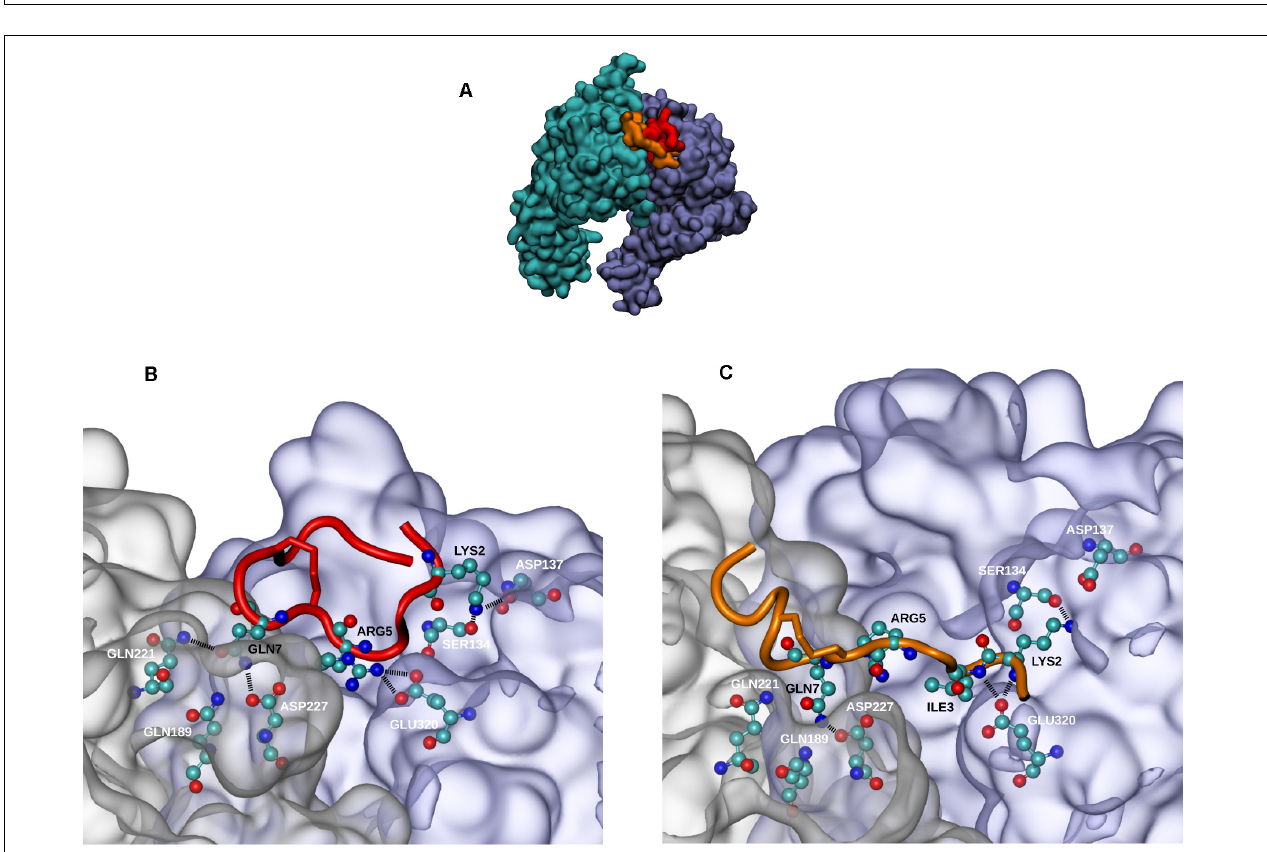
FIGURE 3 | Docking experiments of QS-13 on α 5 β 1 integrin. The best results of QS-13 docking experiment display the same interaction area with the α 5 β 1 integrin at the interface between the two integrin subunits. (A) Integrin subunits and QS-13 are represented using the Quick Surface scheme and colored according to the nature of the chain (cyan for α 5 and magenta for β 1 ) or the conformation of QS-13 (first conformation extracted from the MD in red and second conformation extracted from the MD in orange). (B,C) Zoomed-in representations of the best energy conformation 1 and 2 of QS-13, respectively. The New Cartoon scheme is used to represent QS-13 and the Quick Surface scheme used for integrin is set to transparent. Residues making contacts between integrin and QS-13 (a contact is defined as a distance between two atoms lower than 3 Å) are represented with the CPK mode. Color labels are adopted in order to distinguish integrin (white) and QS-13 (black) residues. Hydrogen bonds are highlighted with thick black dashed